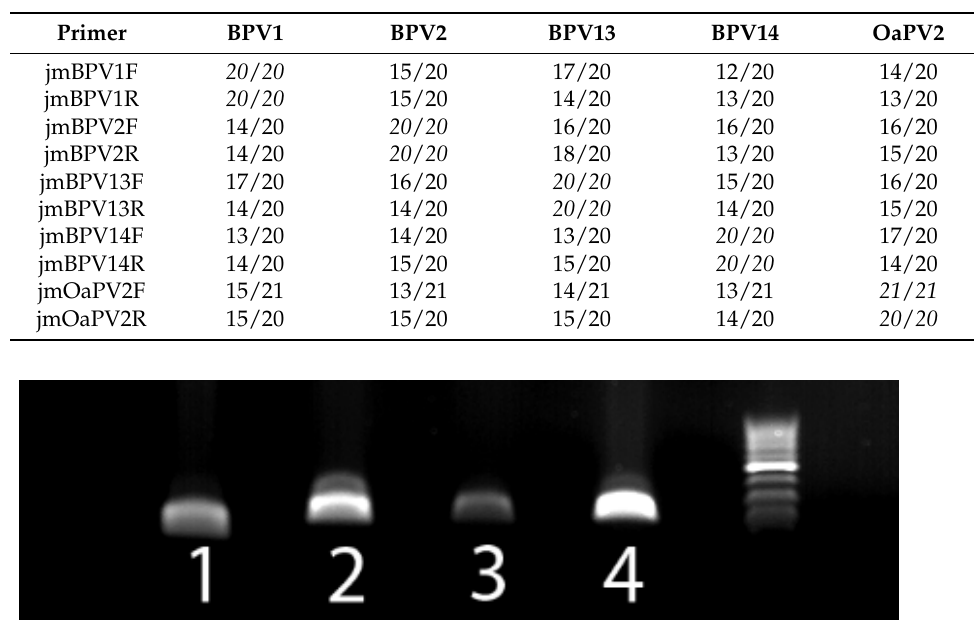
Table 2. Summary of the similarities between each of the primer sequences and the L1 ORF sequences of each of the five deltapapillomavirus types that have been associated with mesenchymal neoplasia. The numerator indicates the number of identical base pairs between the primer sequence and each papillomavirus DNA, while the denominator indicates the number of bases within the primer sequence. BPV is bovine papillomavirus, OaPV2 is Ovis aries papillomavirus.